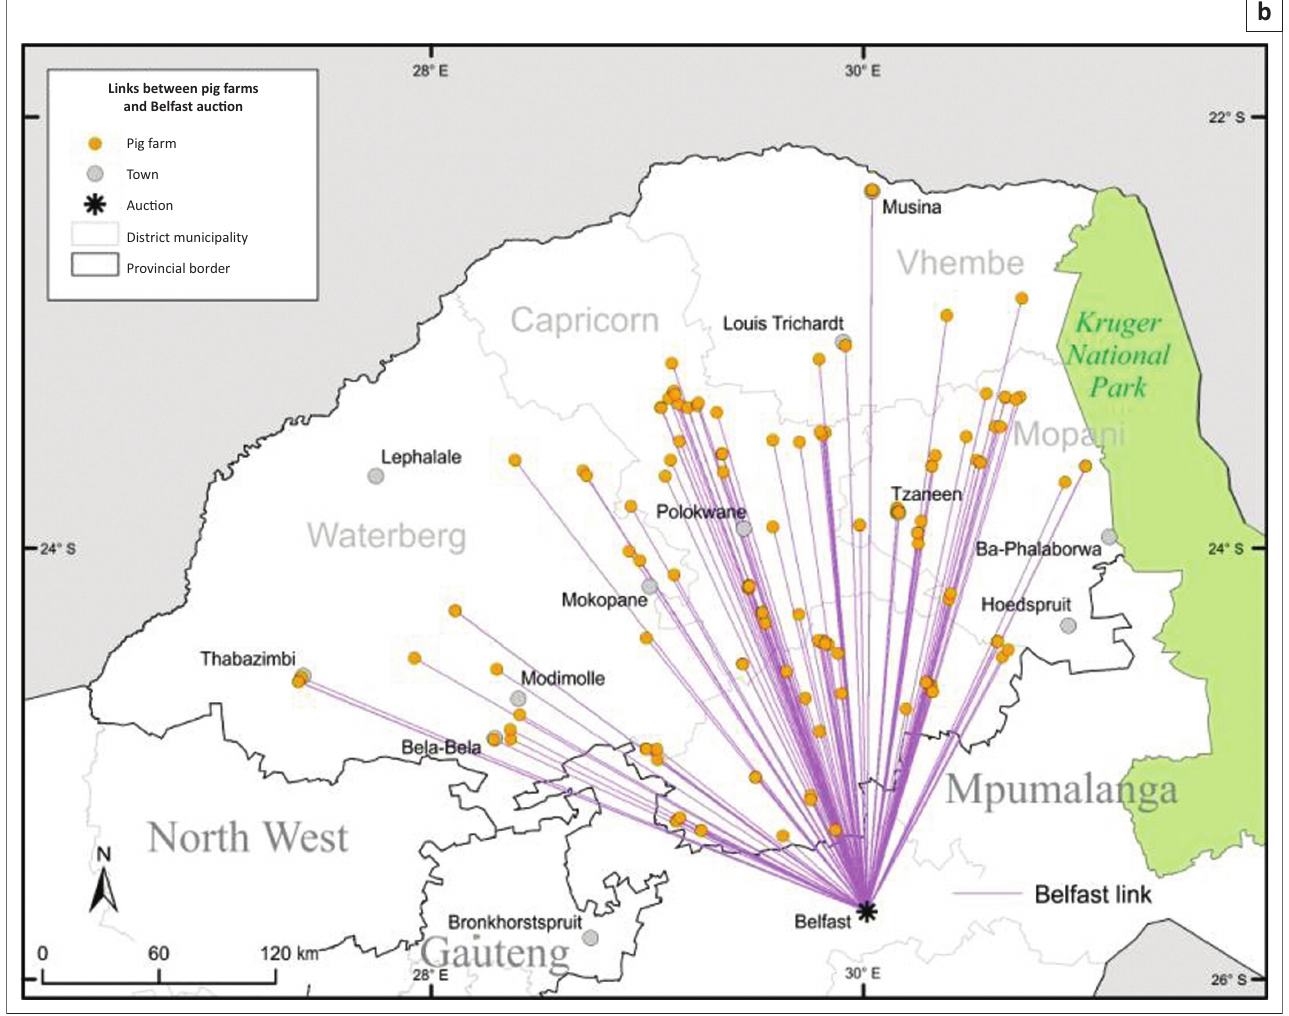
FIGURE 2 (Continues...): (a) Unidirectional links between ESSPF and destinations of final products. (b) Unidirectional links between ESSPF and preferred auction points.